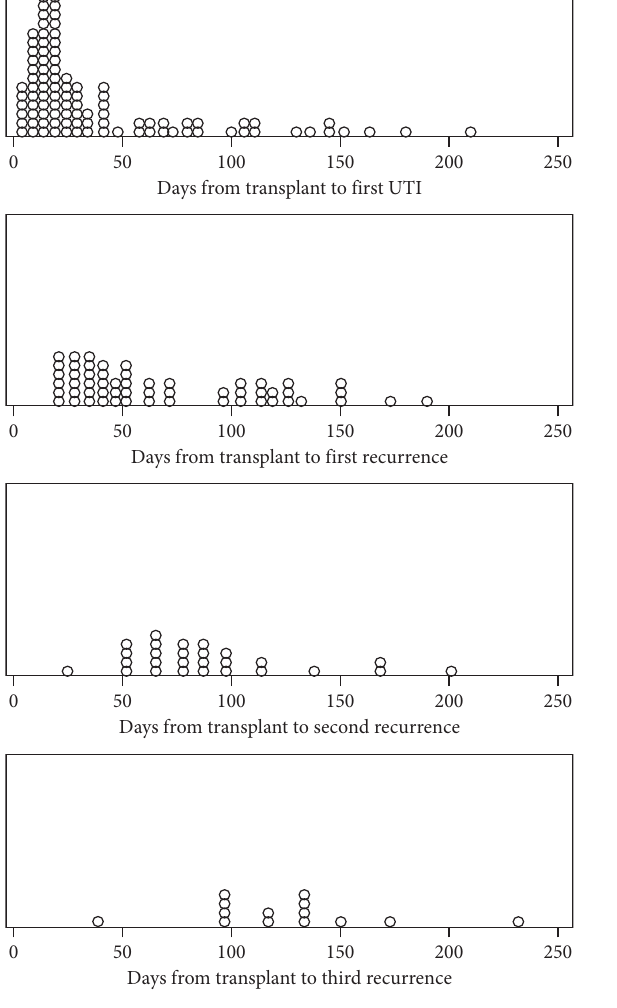
Figure 1: Timing of UTIs and